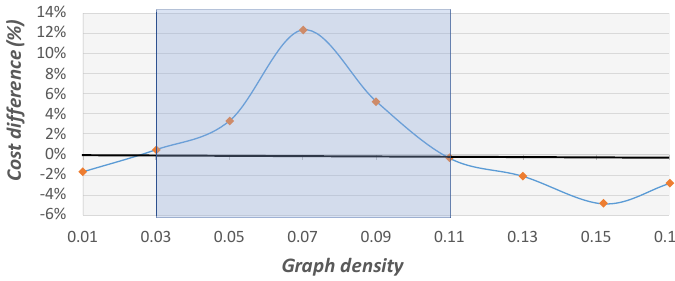
Figure 19. Cost difference comparison on graphs with 2000 vertices at different densities. This graph presents the average cost difference between the solutions of the GA and those of the 2-factor approximation method, which are marked by the fixed black line. The blue region represents graph densities in which the 2-factor approximation method finds better solutions.